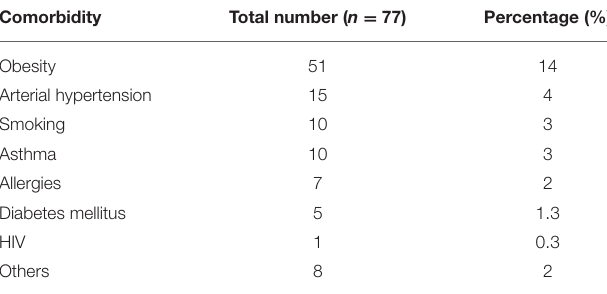
TABLE 2 | Comorbidities showed by institute workers positive to SARS-CoV-2.